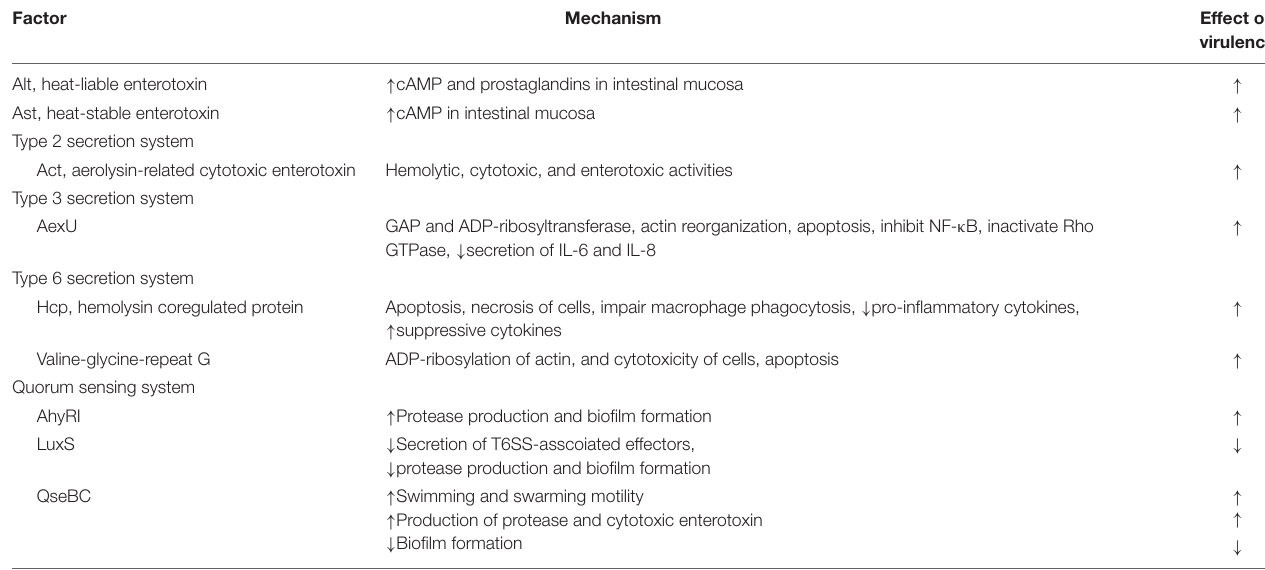
TABLE 1 | Regulatory mechanism of putative virulent factors identified in Aeromonas dhakensis SSU strain. Factor